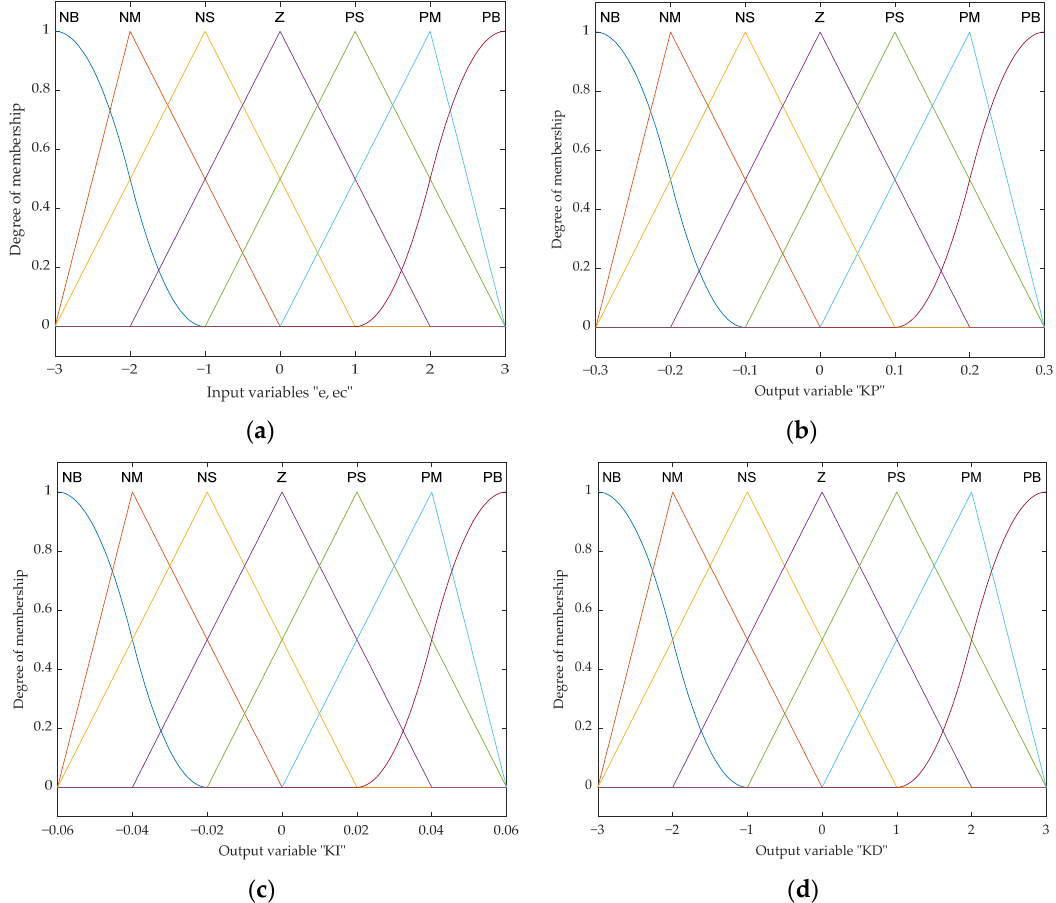
Figure 7. The membership function curves of two input variables and three output variables: ( a ) Input variables e and ec ; ( b ) Output variable K P ; ( c ) Output variable K I ; ( d ) Output variable K D . Table 1. ∆ K P fuzzy control rules.